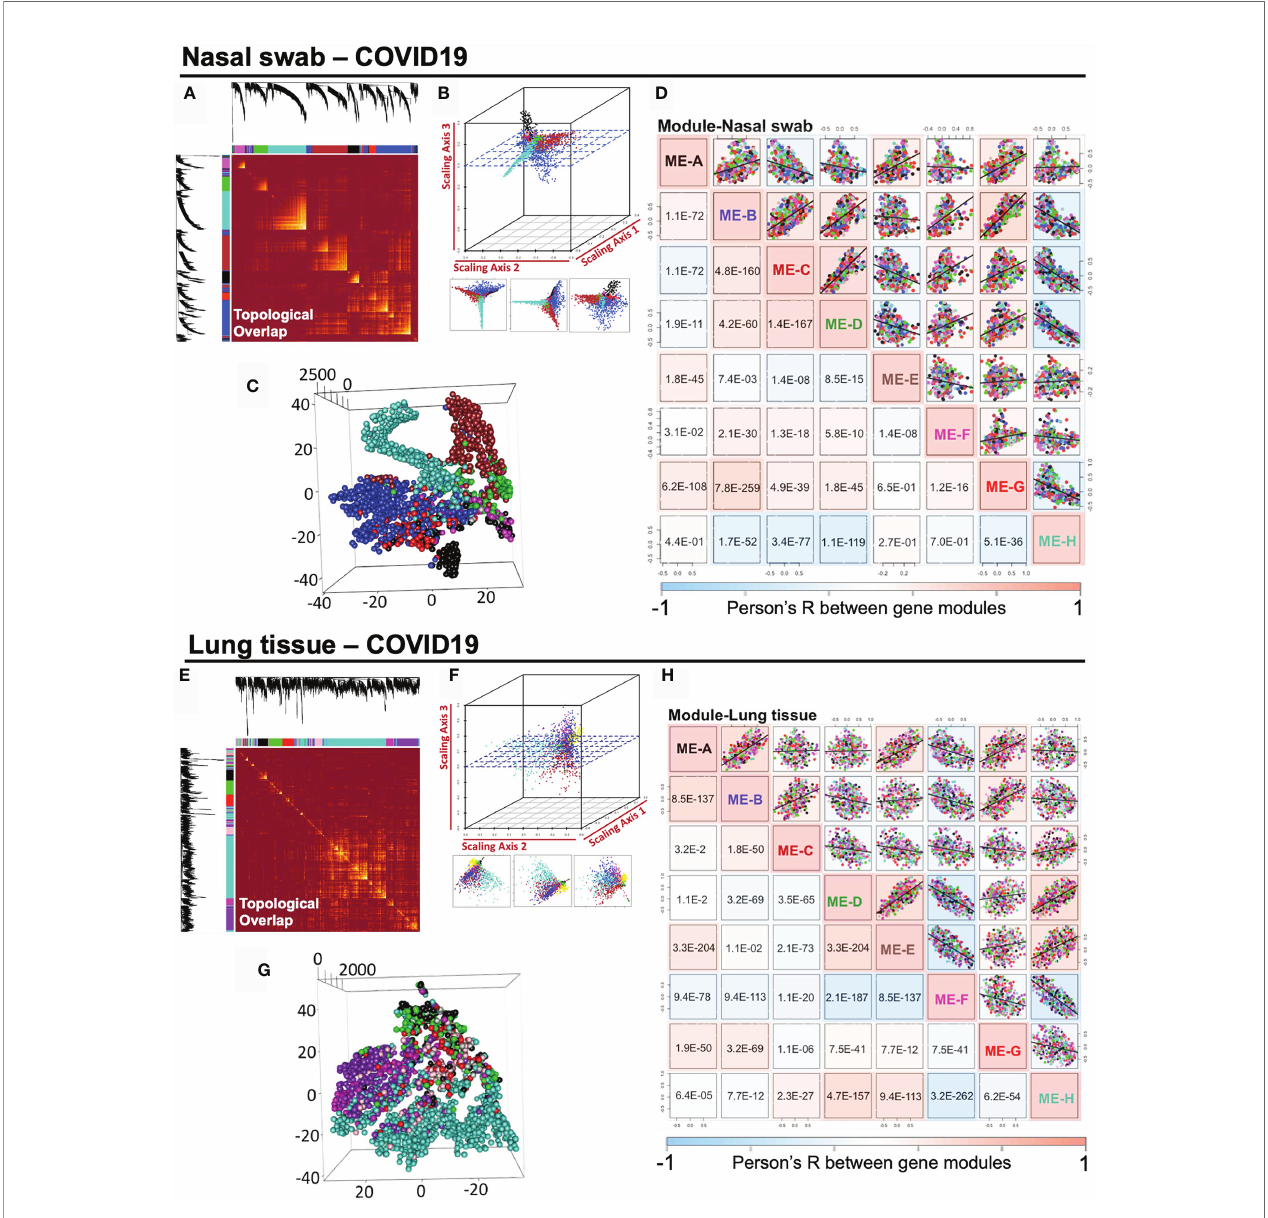
FIGURE 3 | Impact of SARS-CoV-2 infection on the intramodular correlation of co-expression gene modules in nasal swabs and lung tissues. (A , E) A pairwise association of gene modules in a topological overlap plot. (B , F) Geometric data analysis in 3D scattering. (C , G) t-SNE dimension reduction analysis to observe the distribution of gene modules. (D , H) Pairwise illustration of gene module correlation pro fi le indicated by Pearson ’ s R shown in whole pairwise scatterplots in color with p-value in the lower panel (one-way ANOVA with Tukey ’ s multiple